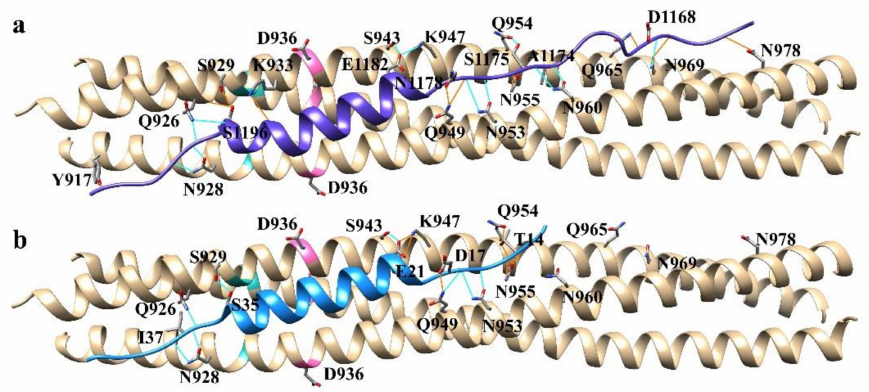
Figure 4. Hydrogen bonding interactions between: ( a ) the SARS-CoV-2 WT HR1 domain and HR2 domain and ( b ) SARS-CoV-2 WT HR1 domain and the EK1 peptide. Hydrogen bonds are shown with blue or orange lines. Blue hydrogen bonds fall within the precise geometric criteria of 2.5 angstroms and theta is greater than 90 degrees [56]. Orange hydrogen bonds fall within the tolerance criteria for H-bond relaxed constraints of 0.4 angstroms and 20.0